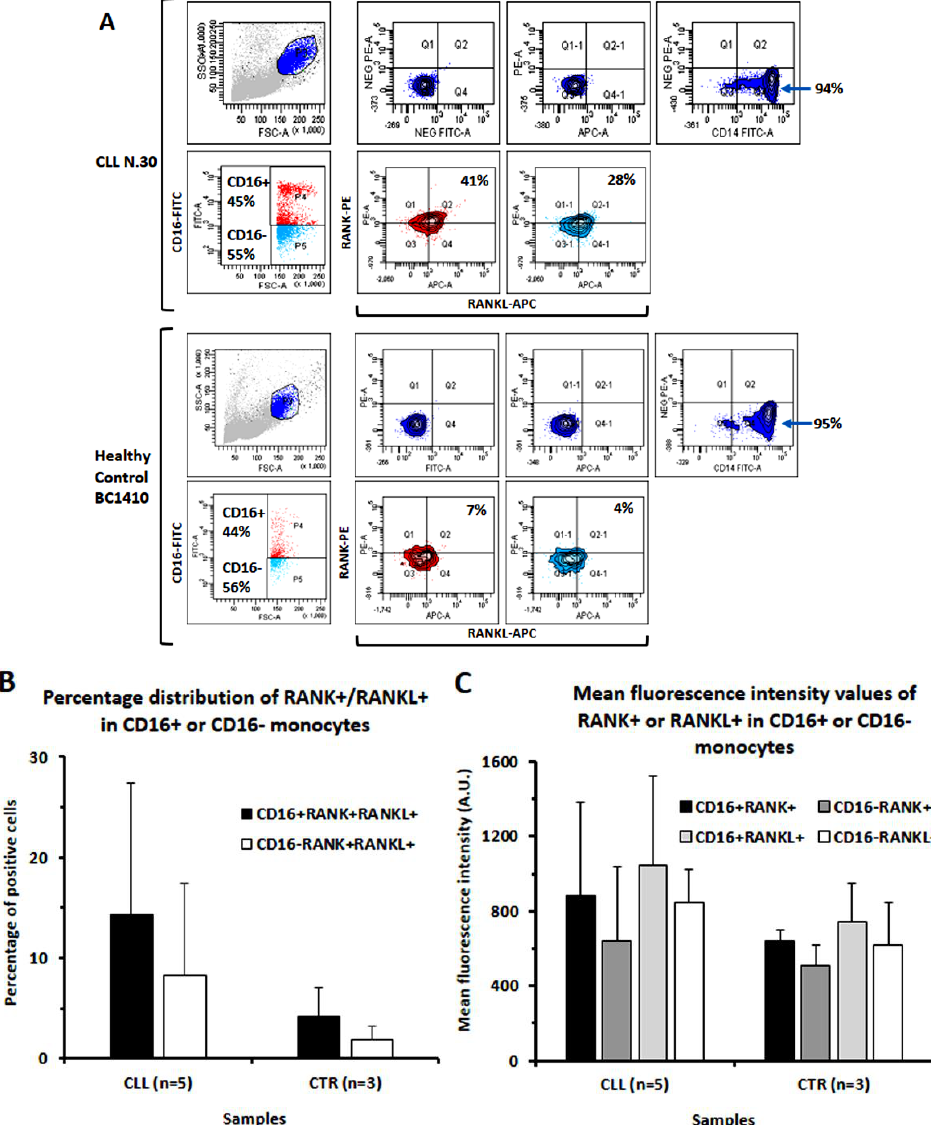
Figure 2. Cyto-fluorographic determination of the percentage of CD16-positive or CD16-negative monocytes contemporarily expressing RANK and RANKL. ( A ) Dot plots display percentages of CD16+/RANK+/RANKL+ (red population) or CD16 − /RANK+/RANKL+ (light-blue population) monocytes of a representative CLL case (N.30) as compared to monocytes from a healthy donor (BC1410). Two separate gates (p4 for CD16+ and p5 for CD16 − ) were applied to differentiate positive and negative cells based on FSC-A and CD16-FITC parameters. ( B ) Histograms highlight that CD16+ monocytes tend to co-express RANK and RANKL and that the triple-positive cells appear in larger proportion in CLL cases (n = 5 examined cases) than in controls (n = 3). ( C ) The same tendency is also shown in terms of mean fluorescence intensity (m.f.i.) within CD16-positive or -negative monocytes, in CLL or in healthy controls.